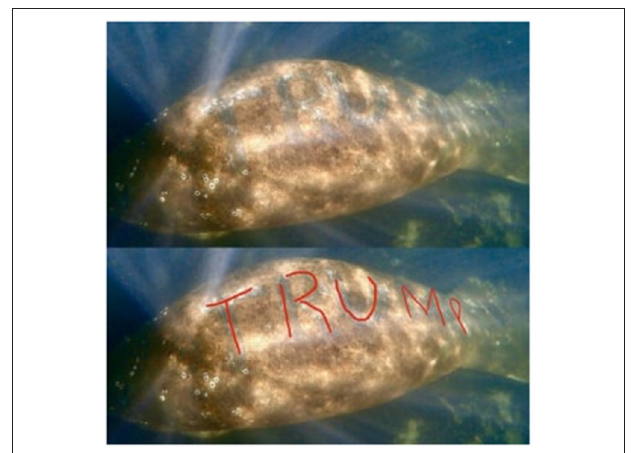
FIGURE 9 | Screen capture from Twitter user